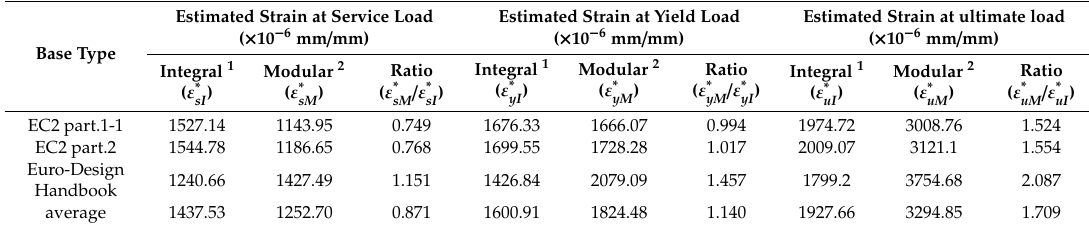
Table 8. Comparison of the estimated strain changes for each load stage.